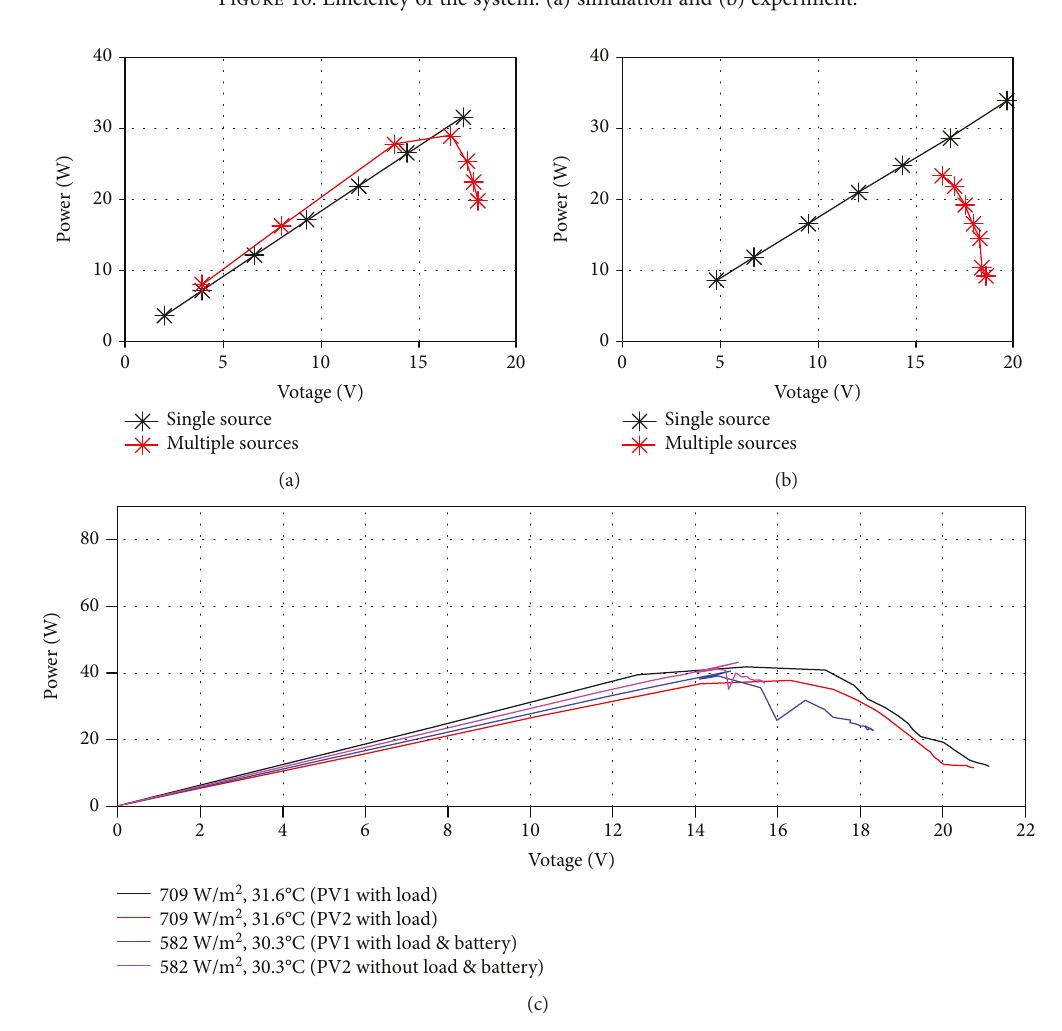
Figure 17: P-V characteristic curves: (a) simulation, (b) experiment, and (c) variations in solar